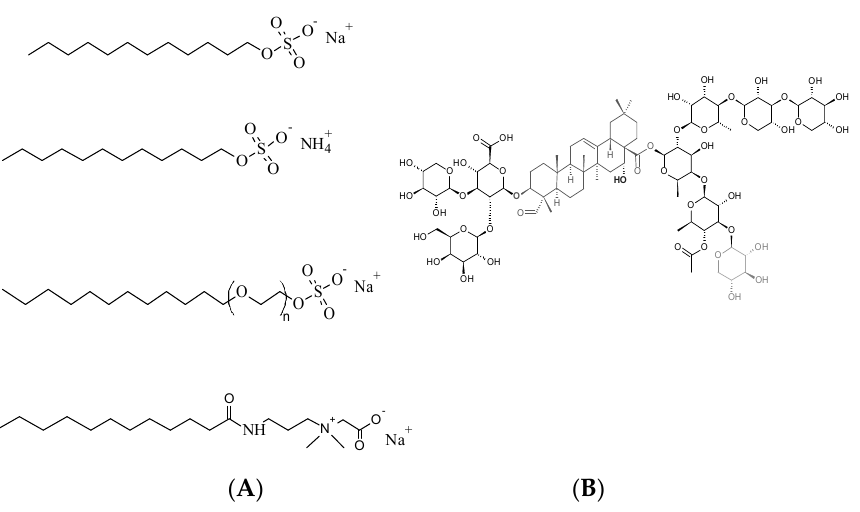
Figure 1. Chemical structures of representative compounds present in: ( A , from top to bottom) sodium lauryl sulfate (SLS); ammonium lauryl sulfate (ALS); sodium laureth sulfate (SLES); cocamidopropyl betaine (CAPB), and ( B ) soapwort extract (triterpenoid saponins).